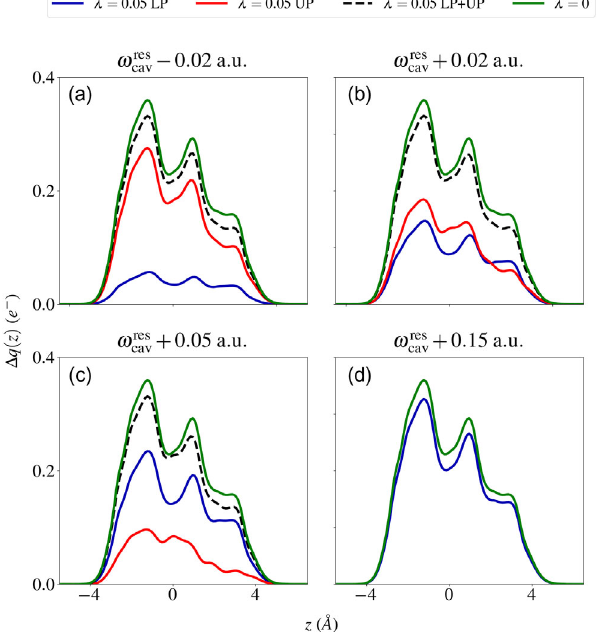
FIG. 8. Potential energy curves in QED-CCSD-1 for pyrrole calculated without (a,c) and with (b,d) the cavity. Panels (c) and (d) are zoom-in views of (a) and (b), respectively, in the conical intersections ’ region. The energies are relative to equilibrium energy. In panels (b) and (d), the blue color map indicates the electronic or photonic character of the